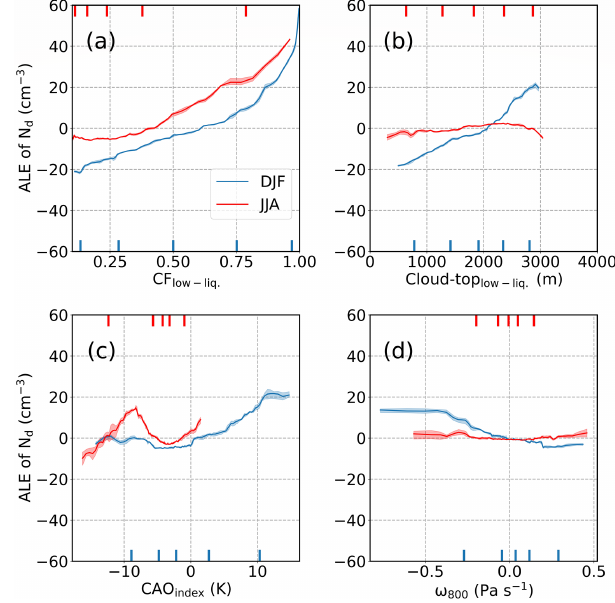
Figure 14. Average local accumulated effect (ALE) profiles based on GBRT modeling for surface mass concentrations of the follow- ing parameters: (a) dust, (b) organic carbon, (c) sea salt, and (d) sul- fate. Blue and red profiles represent ALEs of DJF and JJA, re- spectively. Shaded areas show the ALE ranges stemming from the variability of the obtained models from the cross-validation resam- pling procedure. Markers on the bottom and top x axes denote the values of the 5th, 25th, 50th, 75th, and 95th percentiles for each input variable.